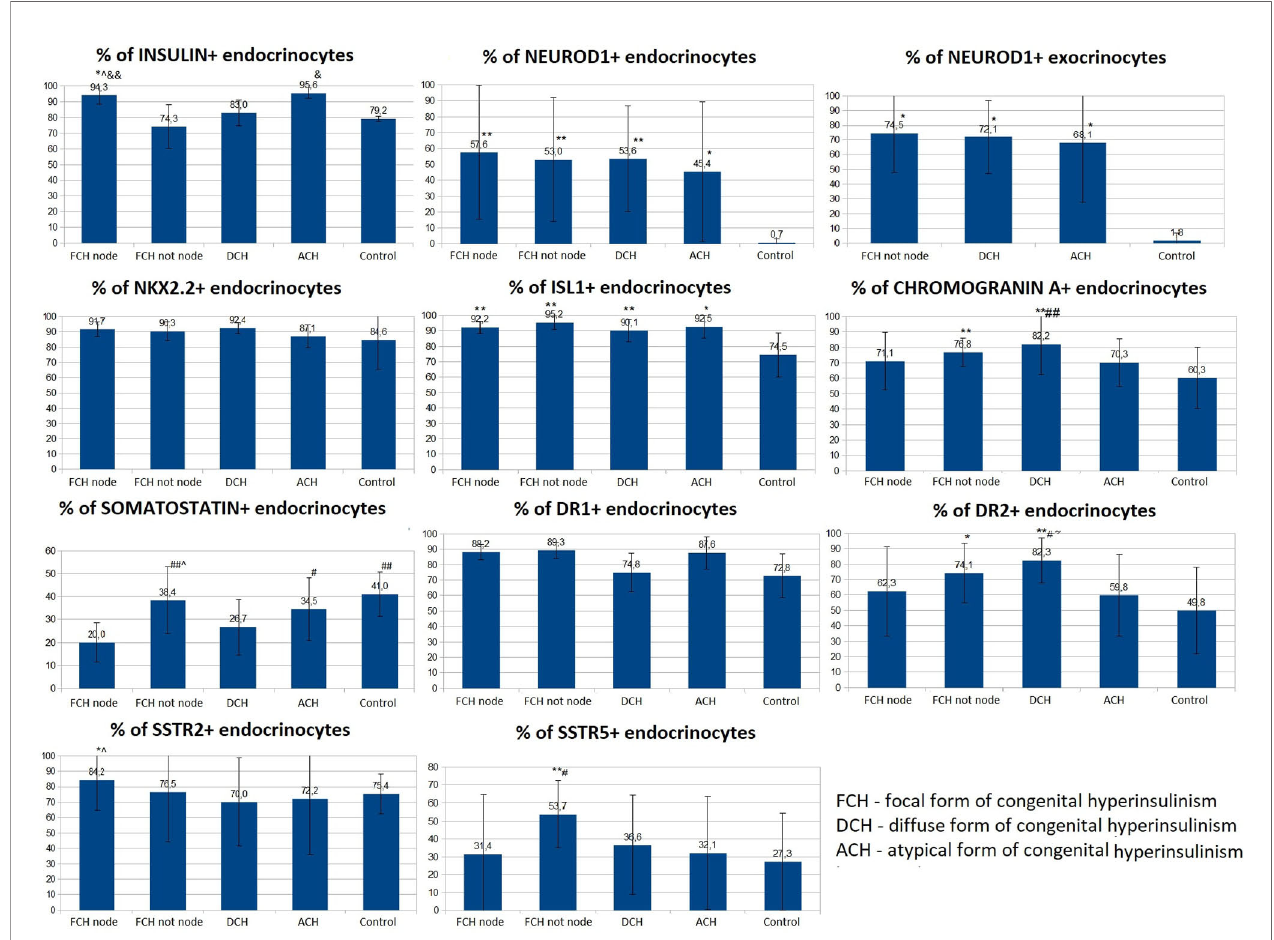
FIGURE 9 | The proportion of endocrinocytes expressing various markers in pancreatic tissue in congenital hyperinsulinism and in control. Data are presented as M ± SD. (*) and (**) - the difference in comparison with the control is statistically signi fi cant at p < 0.05 and p < 0.01 respectively; (#) and (##) - the difference in comparison with the zone of adenomatous hyperplasia is statistically signi fi cant at p < 0.05 and p < 0.01 respectively; (&) and (&&) - the difference in comparison with the area of unchanged tissue in the focal form (CHI-F outside the node) is statistically signi fi cant at p < 0.05 and p < 0.01 respectively; (^) - the difference compared to the diffuse form is signi fi cant at p < 0.05.; (~) - the difference compared to the atypical form is signi fi cant at p